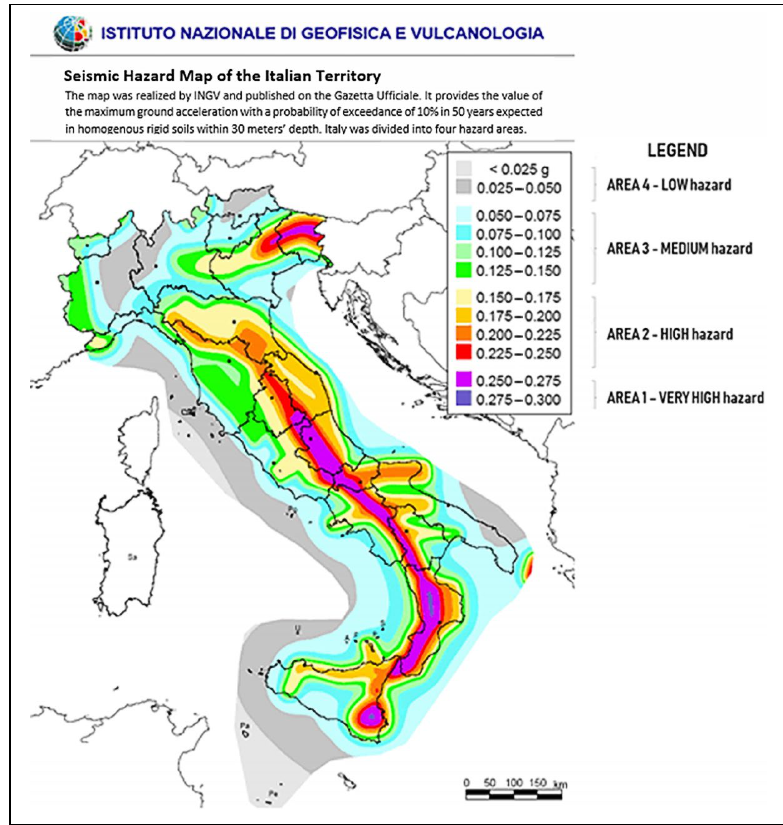
Figure 1. The seismic hazard map of the territory of Italy (Istituto Nazionale di Geofisica e Vulcanologia, n.d.)